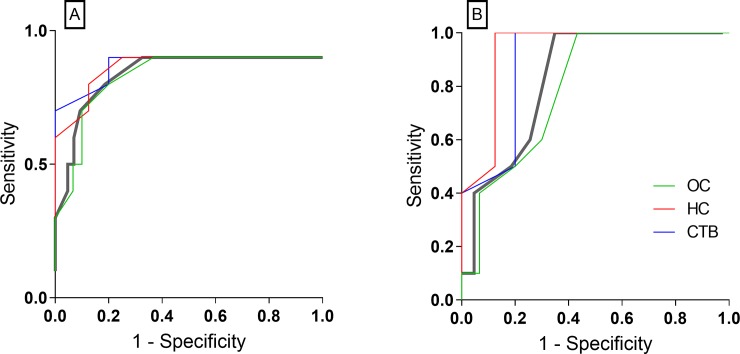
ROC curves with anti-MtM IgM (panel A) and anti-Acr IgA (panel B) antibody levels in HCWs (n = 43) and active TB (n = 10). The thick grey curve in both panels shows results with entire HCW pool and thin, colored curves (key in panel B) depict results for each HCW category: OC (n = 30), HC (n = 8) and CTB (n = 5).